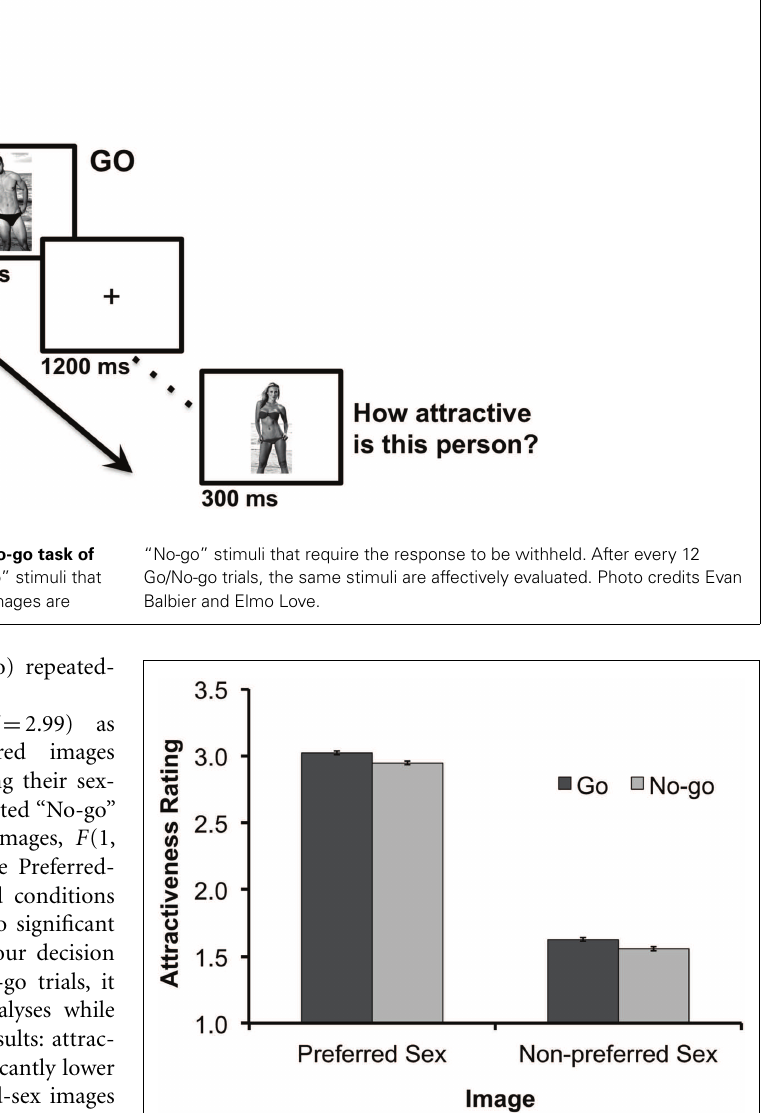
FIGURE 2 | Results of Experiment 1: mean hedonic-evaluation scores for each response type (“Go” vs. “No-go”) and for images of the preferred and non-preferred-sex. Evaluation scores ranged from 1 to 4, with larger values representing more positive hedonic ratings. Error bars represent standard errors of the means based on Loftus and Masson’s (1994) method for within-subjects designs.